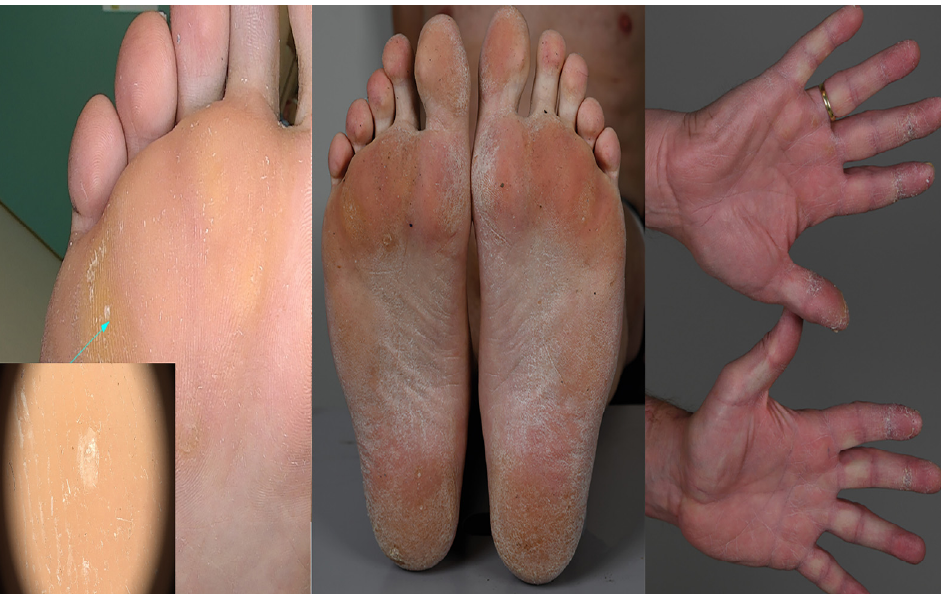
Figure 1. Symmetric palmoplantar keratoderma. Histological examination showed acanthosis with hypergranulosis and compact hyperkeratosis (arrow).